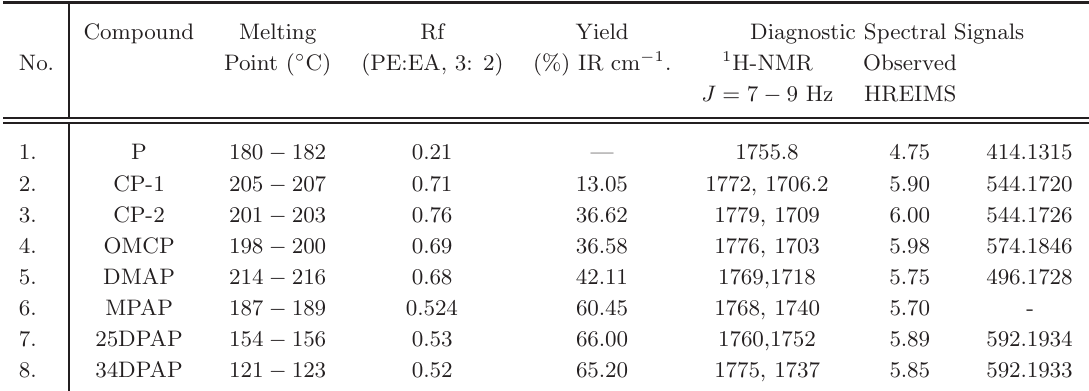
Table 1 Diagnostic spectral detail of the derivatives of